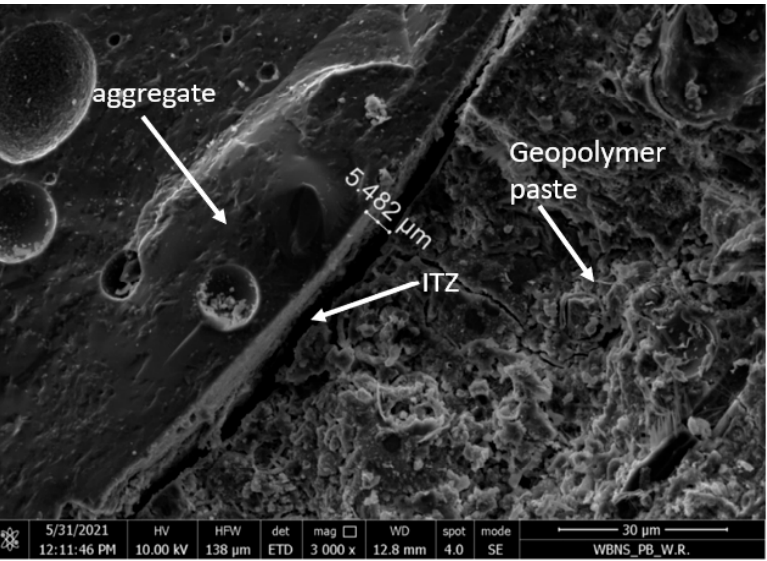
Figure 5. The ITZ between the coarse artificial aggregate and the geopolymer paste (magnified 3000 × ).